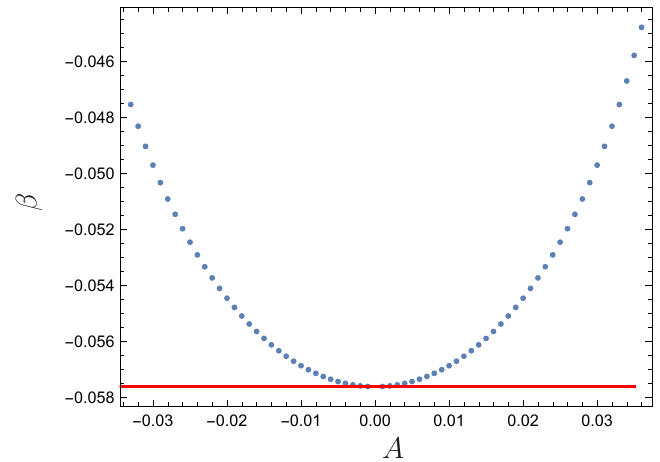
Figure 14 . Dots represent the amplitude of the zero mode β ( A ) as given by (D.54). The solid red line is the perturbative approximation